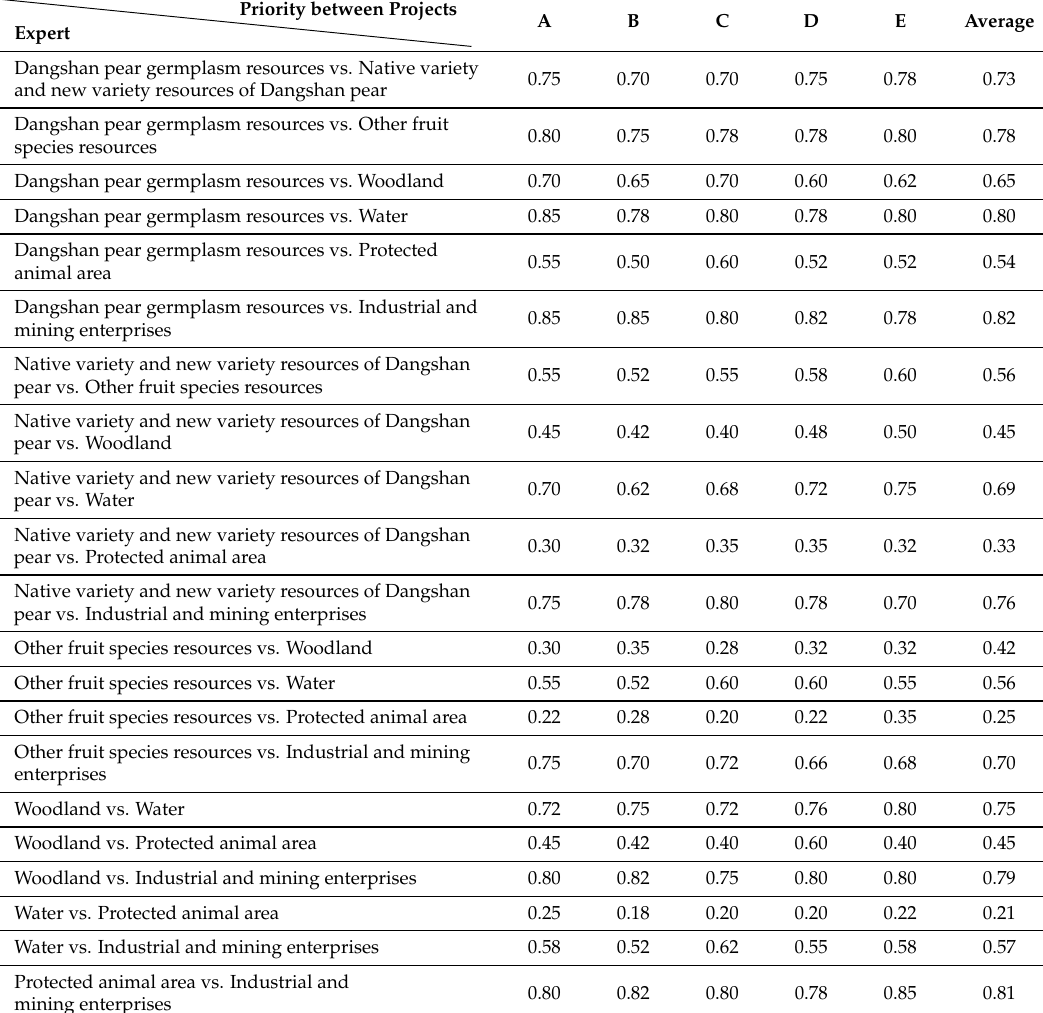
Table 8. Tourist role survey data.